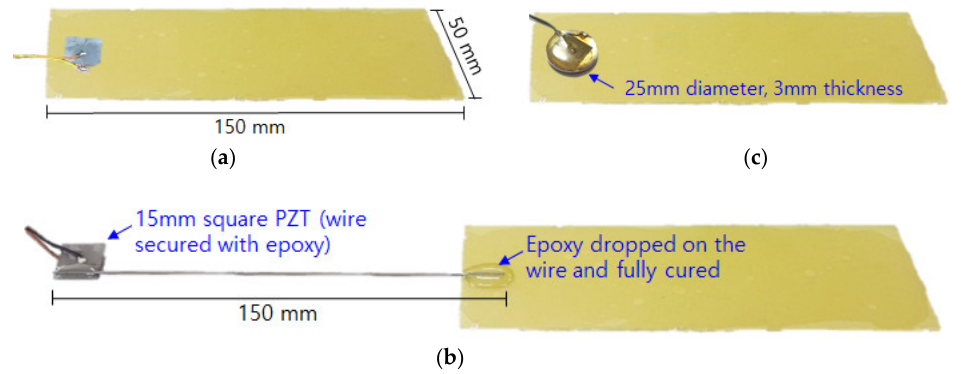
Figure 2. Various PZT attachment methods. ( a ) Conventional PZT attachment; ( b ) Steel wire-PZT attachment; ( c ) Metal disc-PZT attachment.